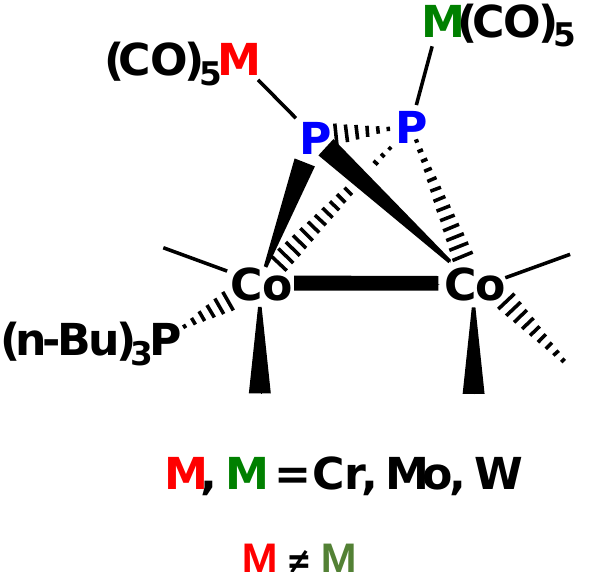
Figure 18. Schematic view of the structure of complex 29 [73].